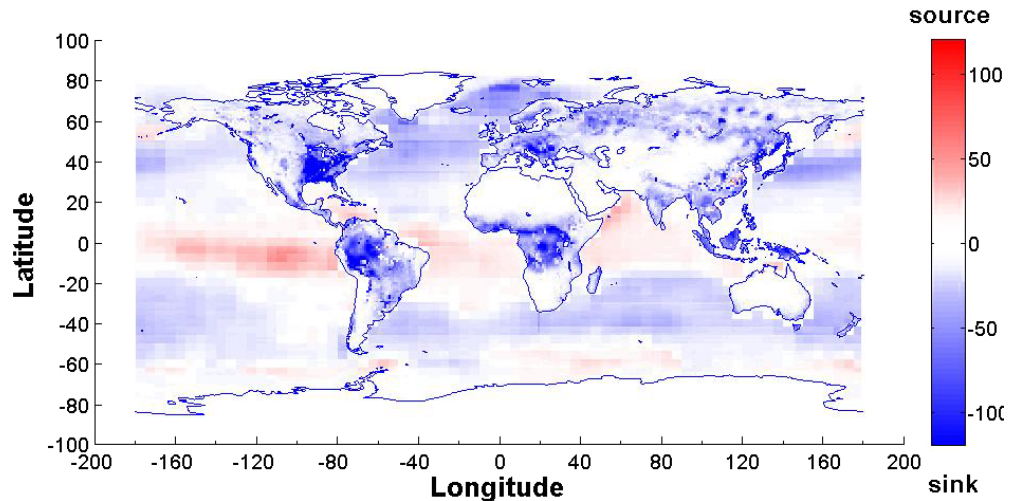
Figure 10. The average annual pattern of the prior flux for the years 2001–2007 excluding fossil fuel and fire emissions (in gCm − 2 yr − 1 ).